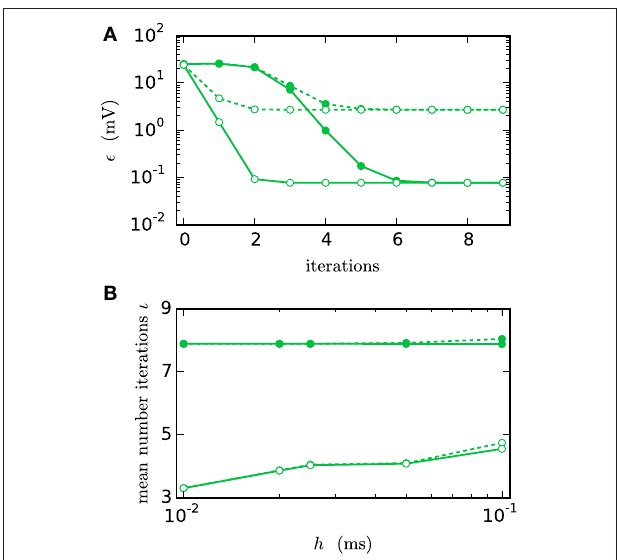
FIGURE 6 | Integration error as a function of the number of iterations. Solid curves indicate cubic interpolation, dashed curves linear interpolation. Filled circles show results for the communication interval of NEST communication, open circles show the results for communication in every time step h . Color indicates the hardware system; in this and all subsequent figures shades of green represent workstations (here) or shared memory cluster node. The RMSE ǫ of the membrane potential was measured over 1 s of biological time. The step size h was chosen as 0 . 05ms leading to r = 1 . 0 0 . 05 = 20 time steps within one minimal delay communication interval. (A) RMSE for different numbers of iterations. (B) Mean number of iterations when using the iteration control with default settings ( prelim_tol chosen as 10 − 4 and a maximum of 15 iterations, which was not reached for any simulation interval).